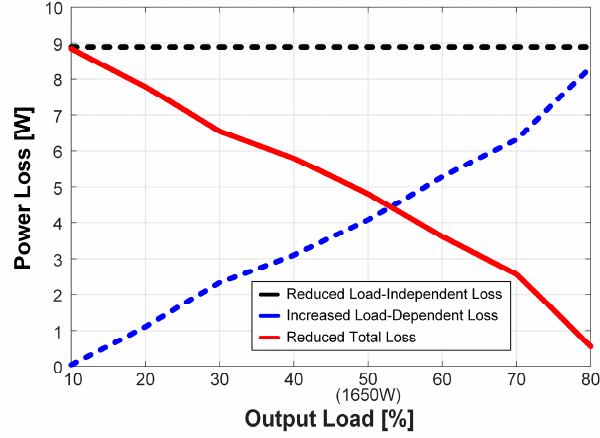
Figure 4. Loss comparison of the modified PFC ON/OFF control and conventional interleaving control at 400 V and 3.3 kW maximum PFC output.